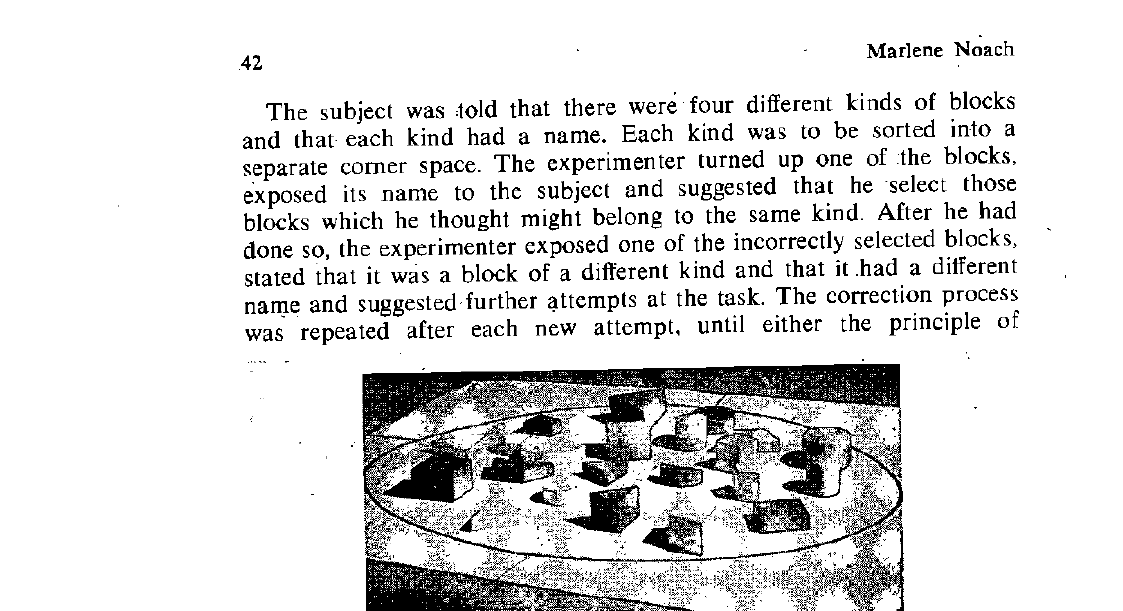
Figure 2. Presentation of Blocks at the Beginning of the